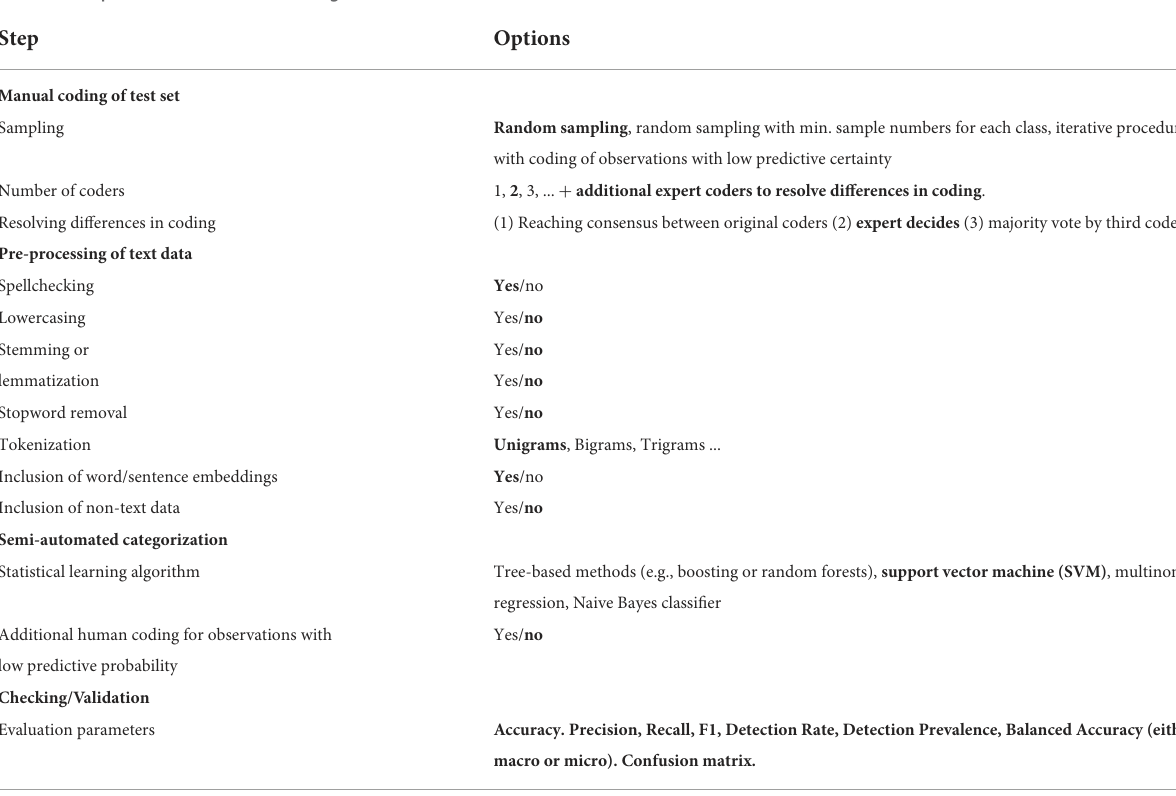
TABLE 2 Steps in semi-automated coding, choice of methods and